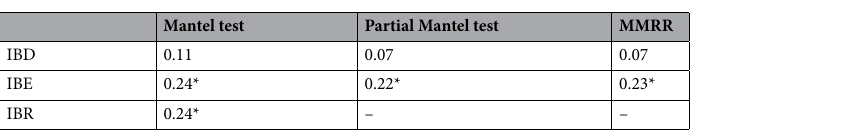
Table 4. Isolation by distance (IBD), isolation by environment (IBE) and isolation by resistance (IBR) analyses among geographic, environmental and genetic distance. MMRR multiple matrix regression with randomization. *Indicates P < 0.05.